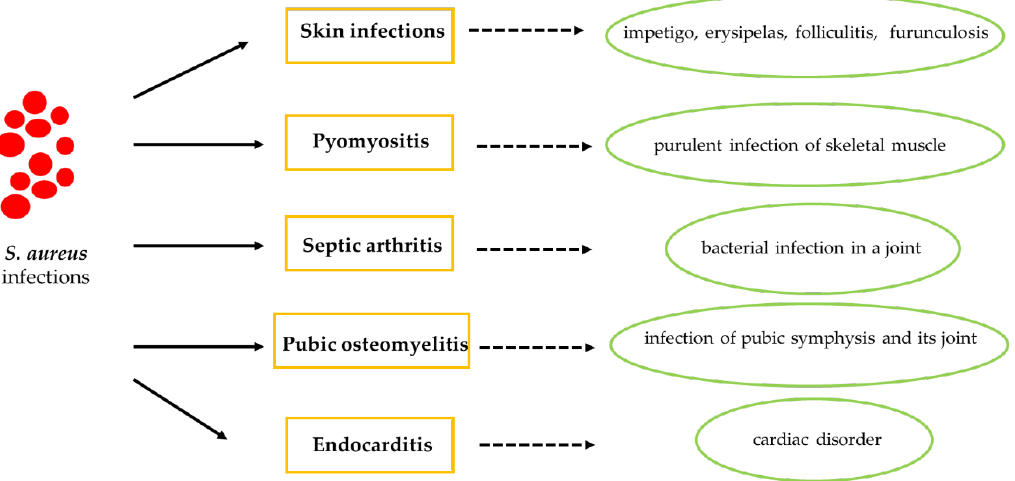
Figure 3. Common infections of Staphylococcus aureus .